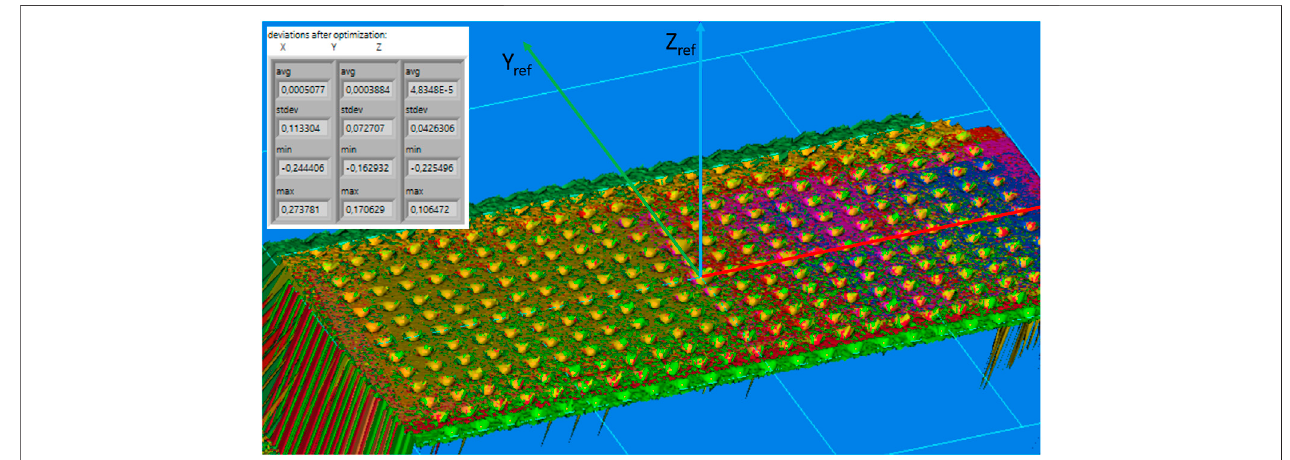
Frontiers in Robotics and AI |